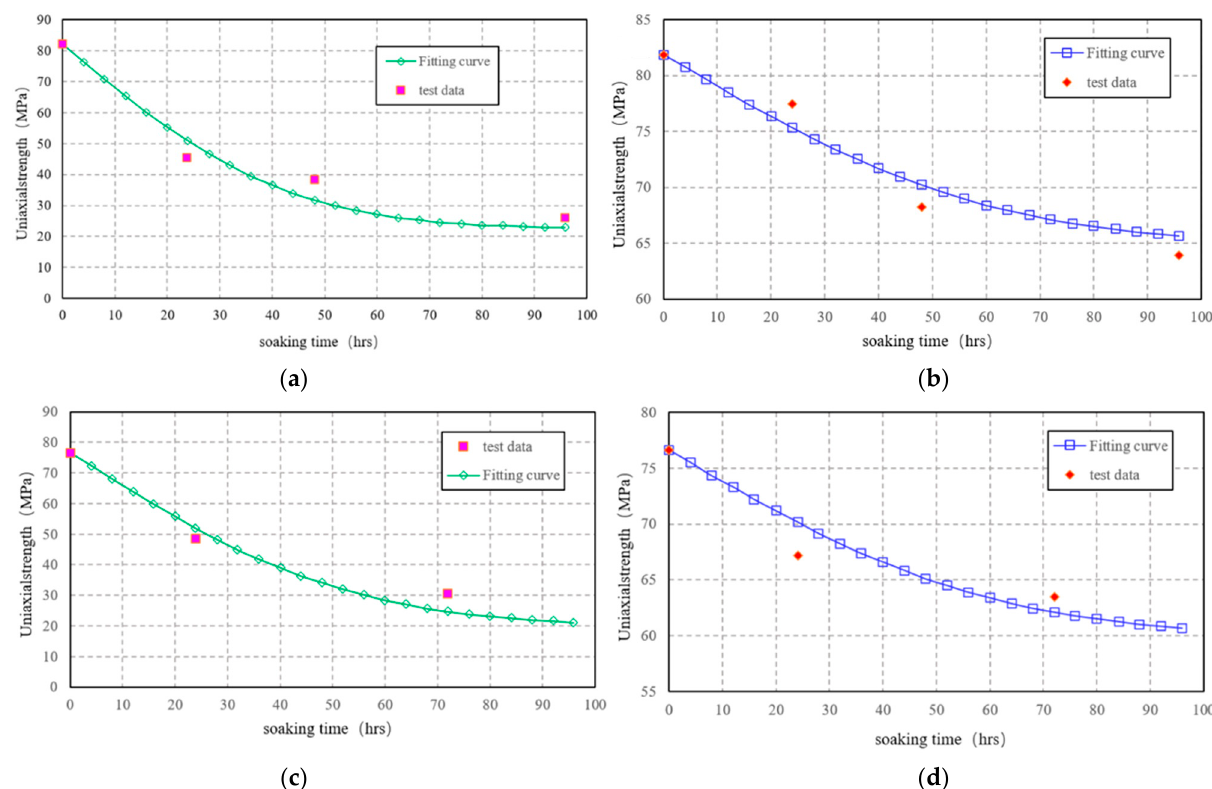
Figure 2. The variation of mud shale strength of Well A and Well B with different drilling fluids and soaking times. ( a ) Well A, water-based drilling fluid; ( b ) Well A, oil-based drilling fluid; ( c ) Well B, water-based drilling fluid; ( d ) Well B, oil-based drilling fluid.